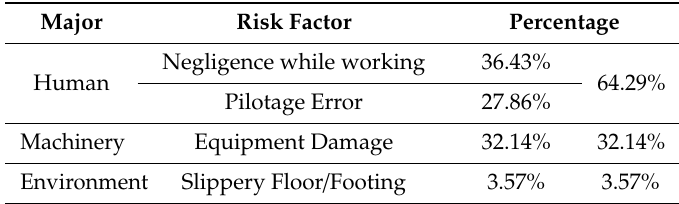
Table 9. Common causes of work